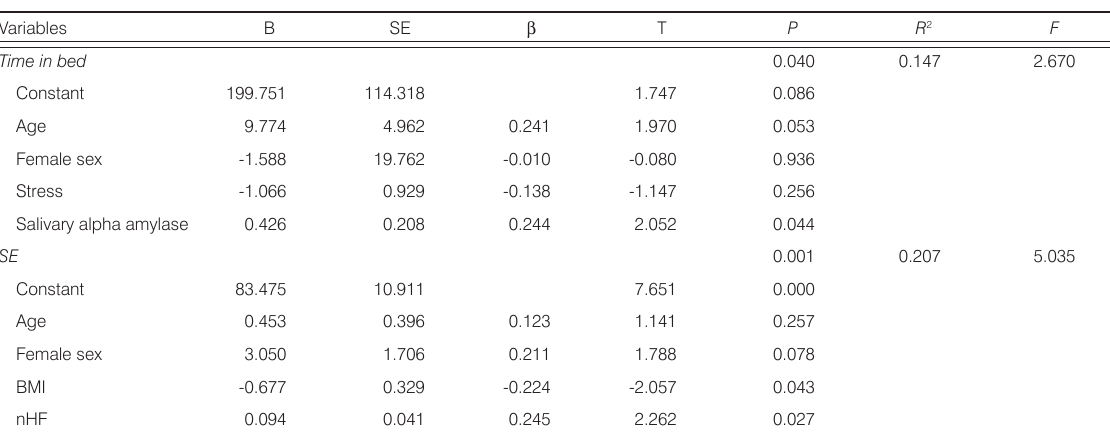
Table 4. Factors influencing time in bed and sleep